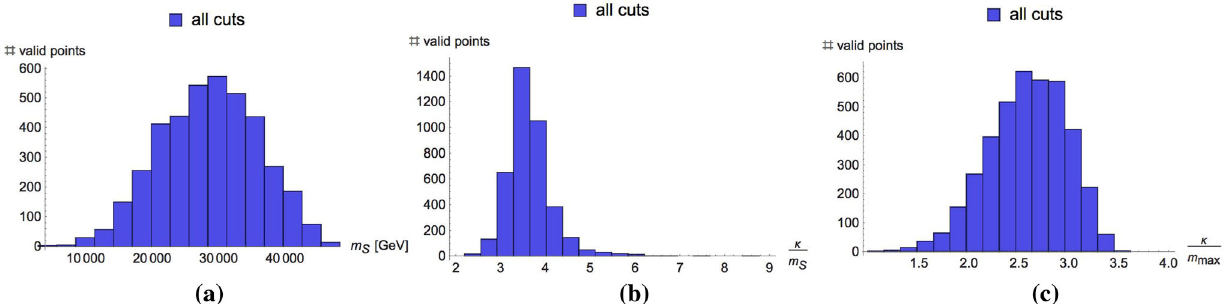
Fig. 1 Left: distribution of points as a function of m S . There is a clear cutoff at m S ∼ 47 TeV. Middle: the ratio of the coupling κ against m S . While it peaks at around 3.5, there are values around 9, too. Right: the